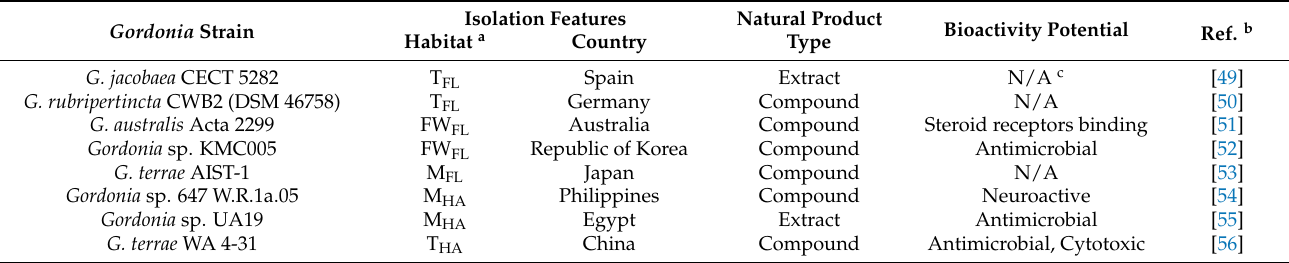
Table 1. Summary of data collected from the articles